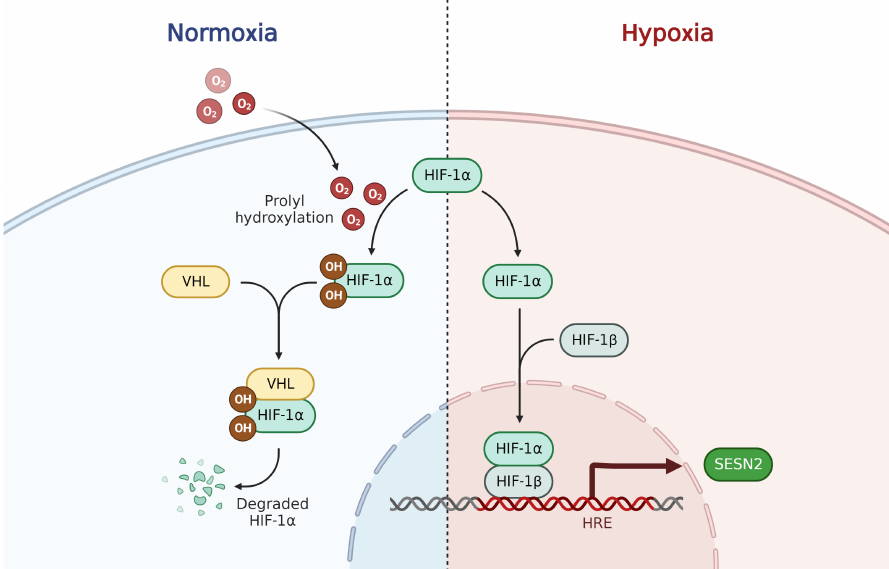
Figure 2. The regulation of SESN2 in response to hypoxic stress. During normoxia, the cellular levels of HIF-1 α remain low due to VHL-mediated proteasomal degradation facilitated by the hydroxylation of the proline residues. Hypoxia prevents the degradation of HIF-1 α and in association with HIF-1 β , the complex translocates to the nucleus to regulate the expression of genes under its transcriptional control. HRE: Hypoxia Response Element; VHL: Von Hippel–Lindau tumor